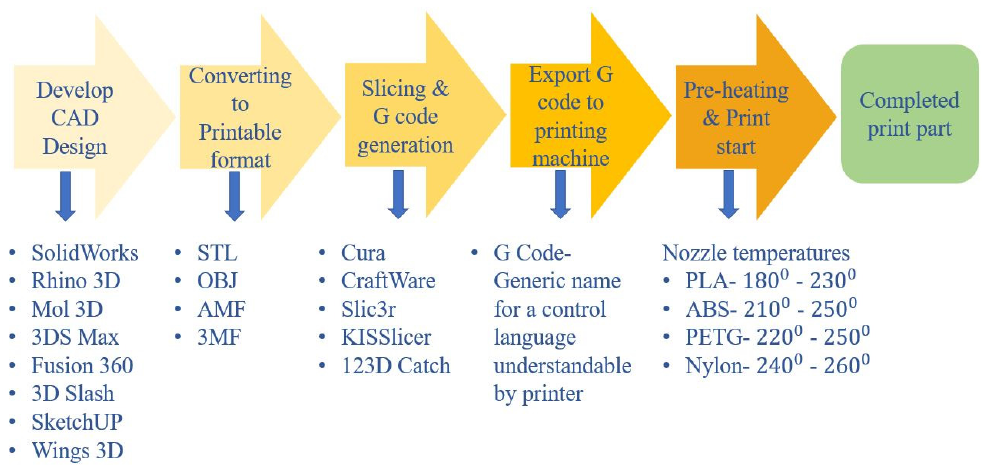
Figure 5. Simplified process flowchart of FDM including di ff erent types of software used in the 3D printing industry. (STL- Stereolithography file, OBJ- Wavefront 3D Object File, AMF-Additive manufacturing file, 3MF- 3D manufacturing